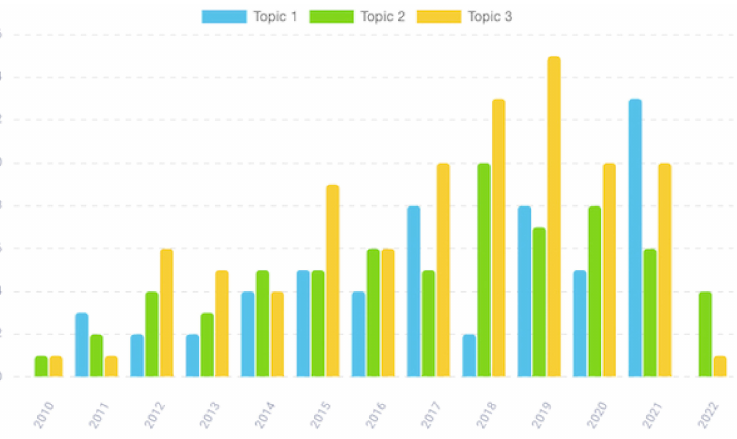
Figure 4. Topic papers over